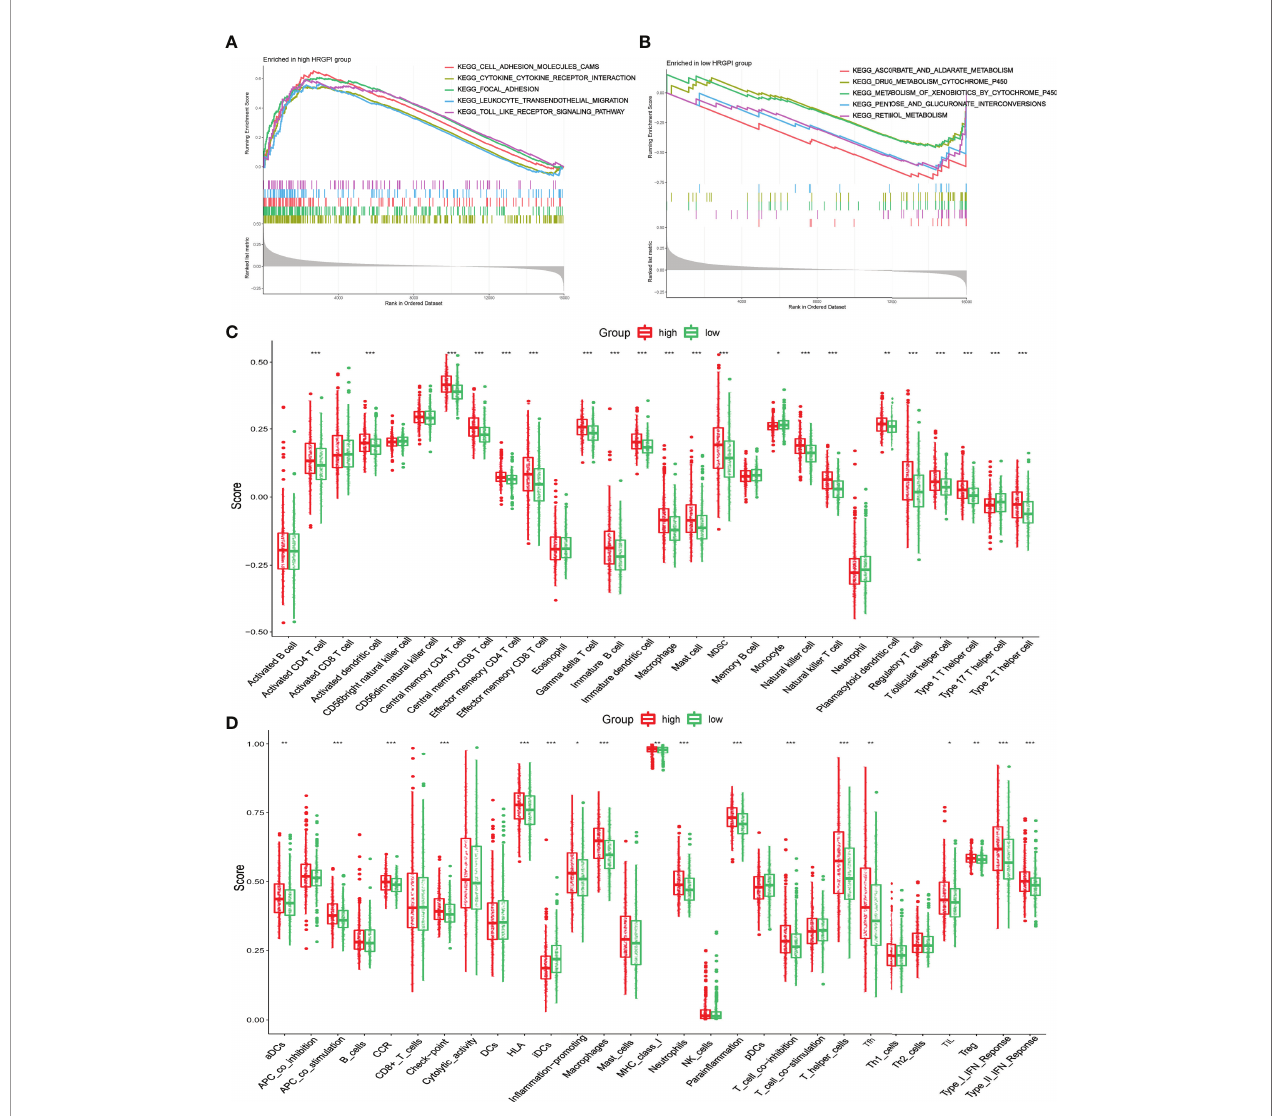
FIGURE 6 | Biological process and immune characteristics of different HRGPI groups (A, B) Distinct KEGG pathways enrich in different HRGPI groups by GSEA algorithm. (C) In fi ltration immune cells were distinct in different HRGPI groups. (D) Different activation of immune functions in different HRGPI groups. ( p < 0.05 *; p < 0.01 **; p < 0.001